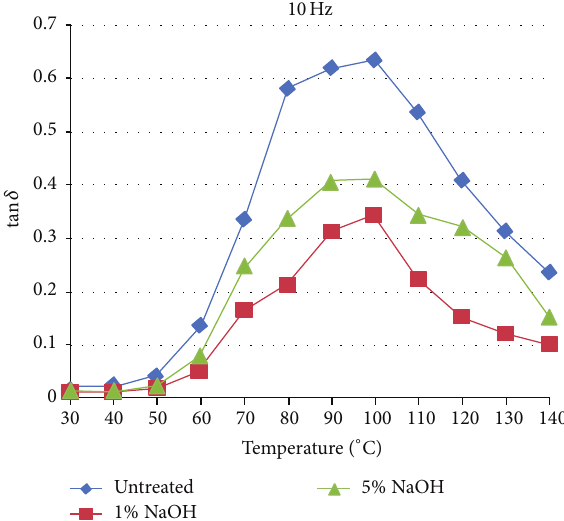
Figure 3: tan 𝛿 versus temperature curves of alkali treated and untreated composites [35].